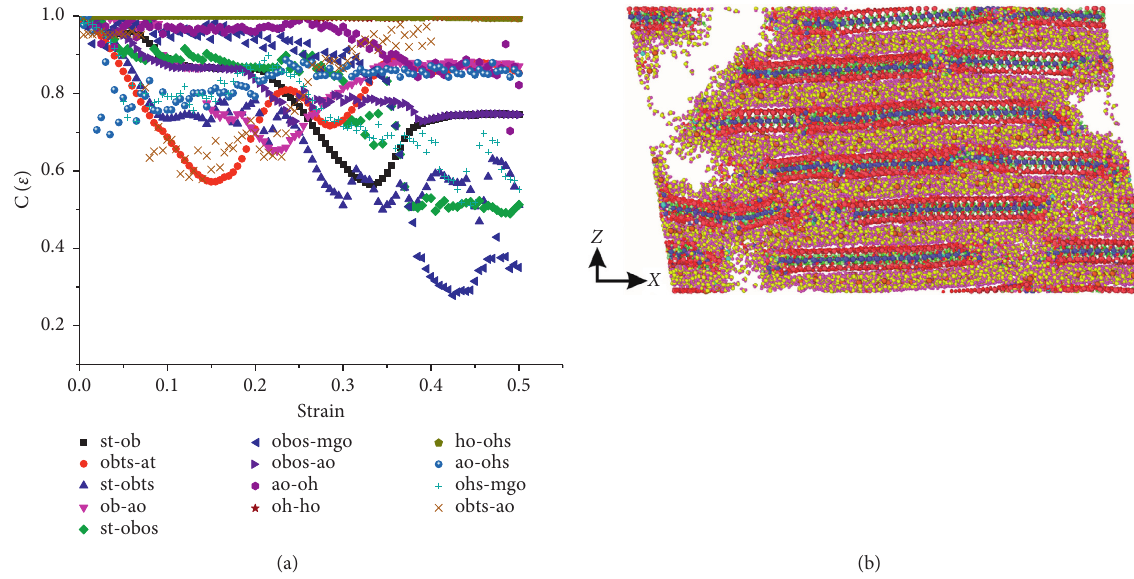
Figure 8: Pull-off failure of Na-MMT-3W in the X direction at 300K. (a) SCF; (b) pull-off failure at strain of